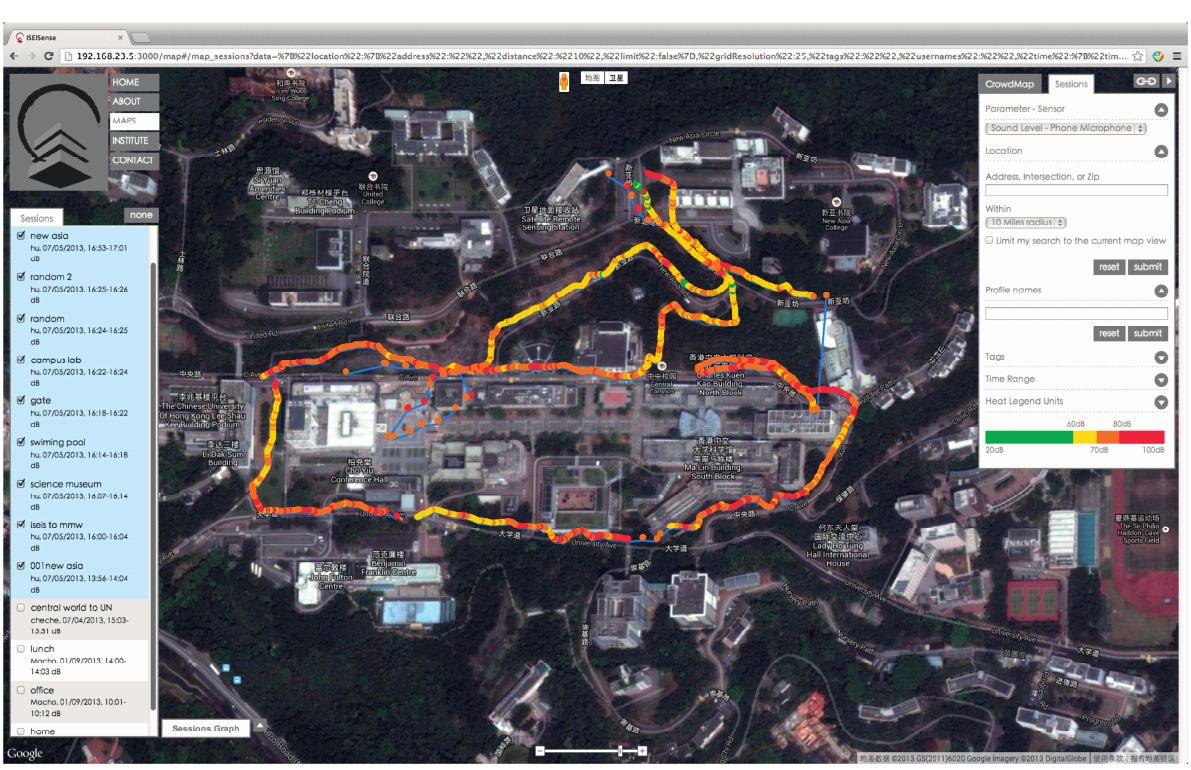
Figure 4. Participatory noise information stream for the main road networks collected by volunteers via the CUHK noise